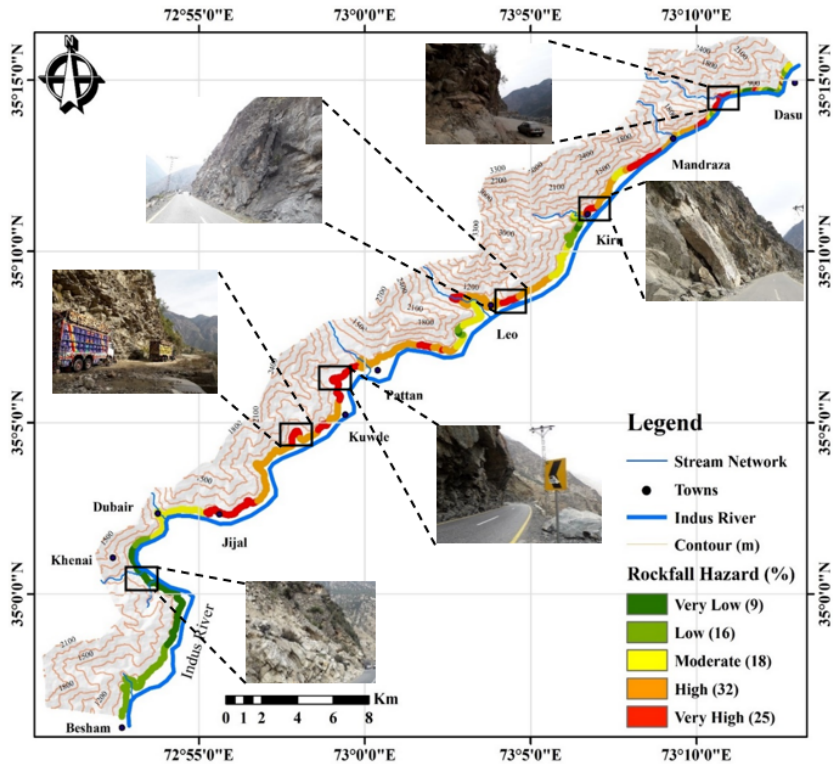
Figure 8. Rockfall Hazard map along the Karakoram highway from Besham to Dasu.